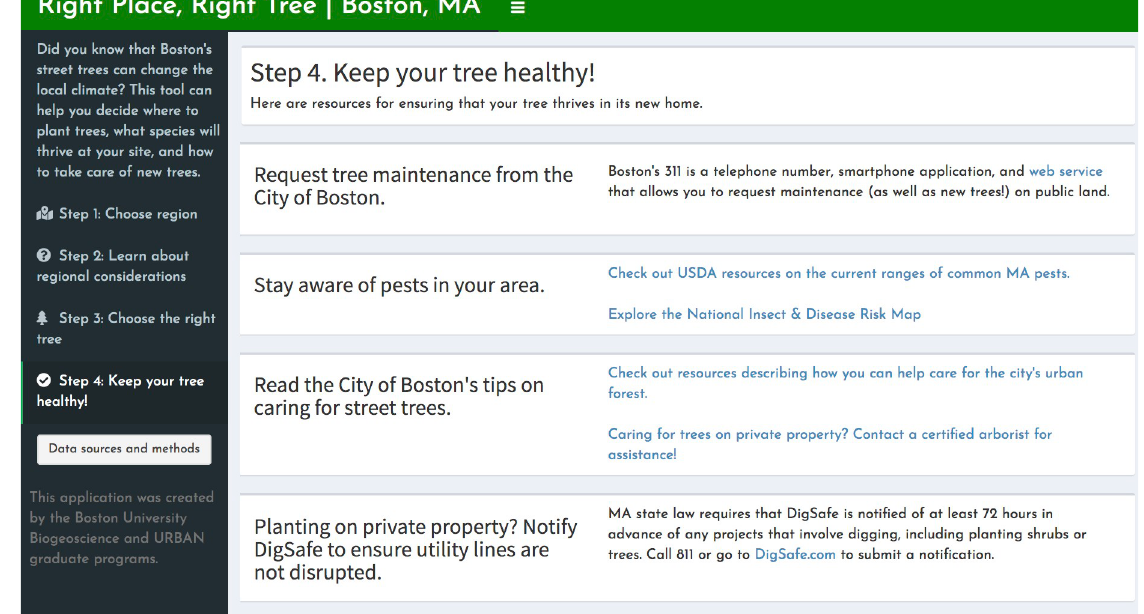
Fig 4. “Step 4: Keep your tree healthy”. The fourth page of the tool provides users with resources that can be consulted for maintenance of the tree they have selected using steps 1 through 3. This includes links for contacting Boston’s tree maintenance teams, up-to-date information about pests, and tips for maintenance from the Boston.gov